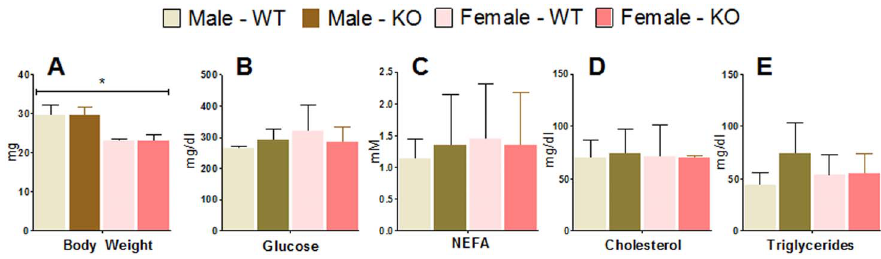
Figure 3. Weights and Serum substrate levels of wild type and cs-ER a 2 / 2 . (A) Weight of mice at the time of study ranging 18–20wks. Serum substrate concentrations of (B) Glucose, (C) NEFA, (D) Cholesterol and (E) Triglyceride were determined by spectroscopic analysis. Data are represented as mean 6 SD (N=4 for each category). *indicates sex difference P , 0.05, Two-Way ANOVA.